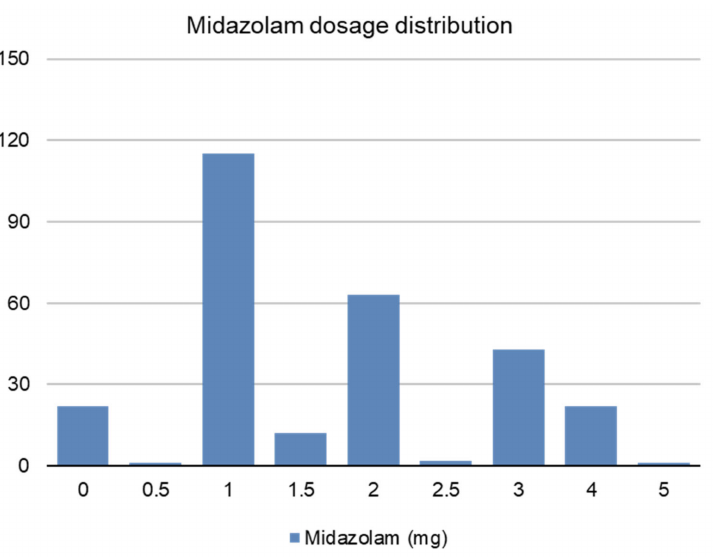
Figure 2. Midazolam dosage distribution. Table 2. Follow-up